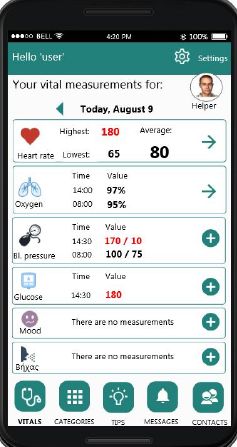
Figure 11. Home screen after applied changes based on the user-based evaluation results.